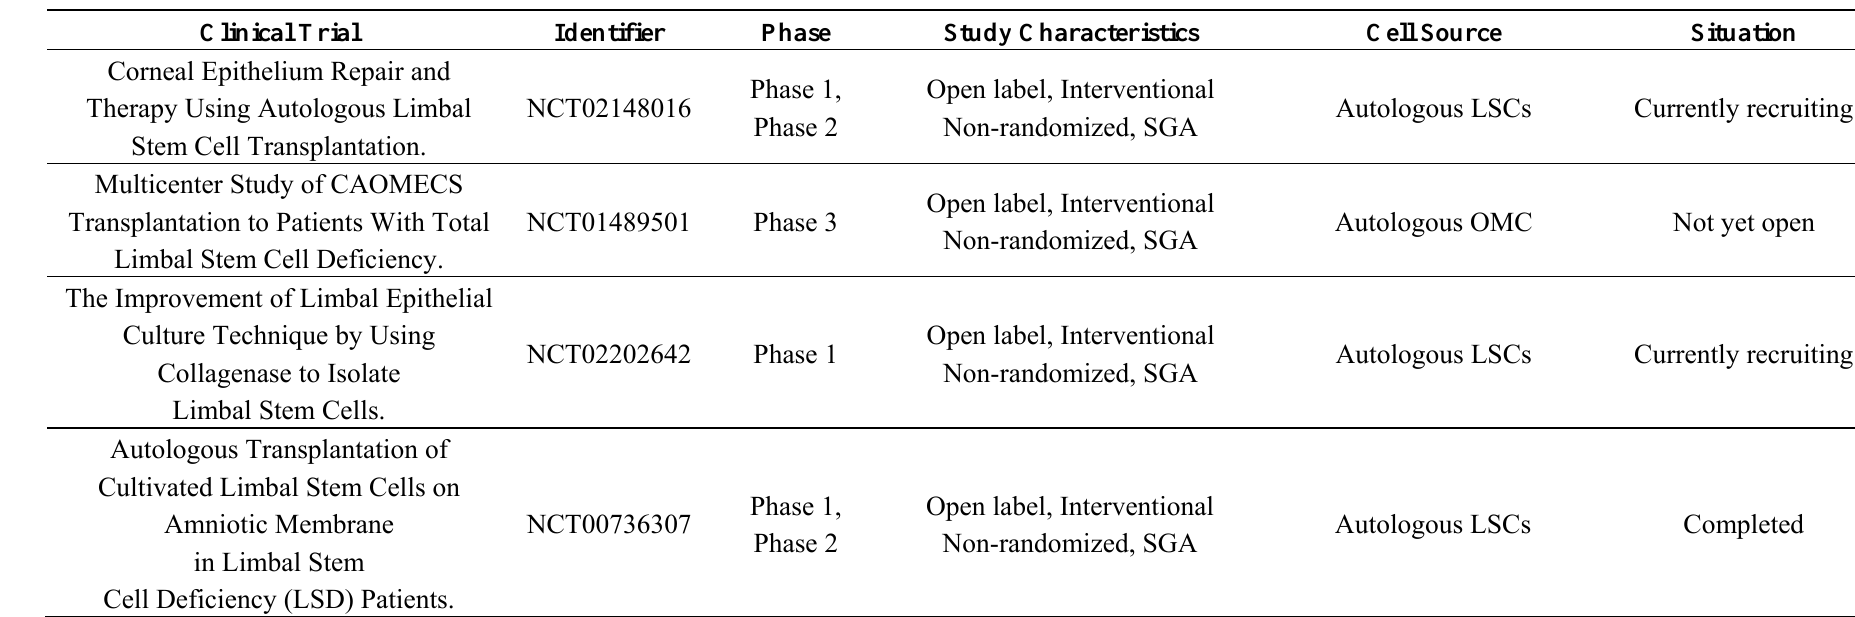
Table 3. Current cell-based therapy clinical trials for the treatment of Limbal Stem Cell Deficiency